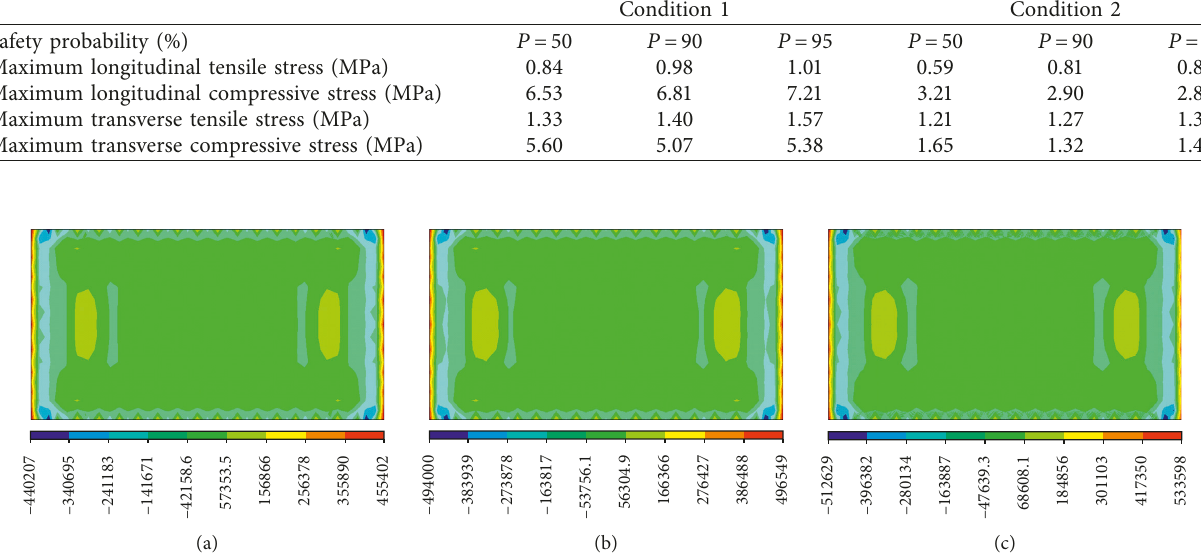
50%. (b) P 90%. (c) P 95%. (cid:31) (cid:31) (cid:31)